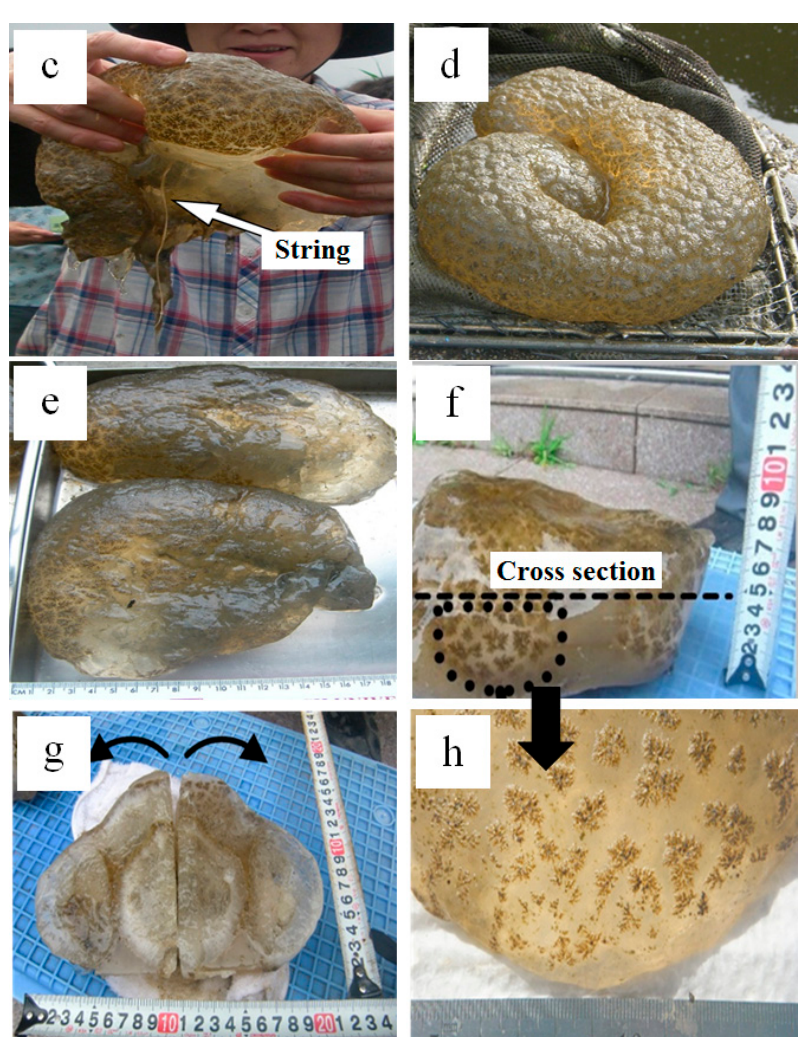
Figure 2. Colonies of Pectinatella magnifica appearing during the summer season in polluted freshwater environments at Shibayama Lagoon ( a , b ); Kahokugata Lake ( c , d ); and Makiyama agricultural reservoir pond ( e ) in Ishikawa Prefecture, Japan. The frozen Pectinatella magnifica collected from Makiyama agricultural reservoirs ( f ); a normal pattern of zooid clusters ( g ); and statoblast pattern on the surface ( h